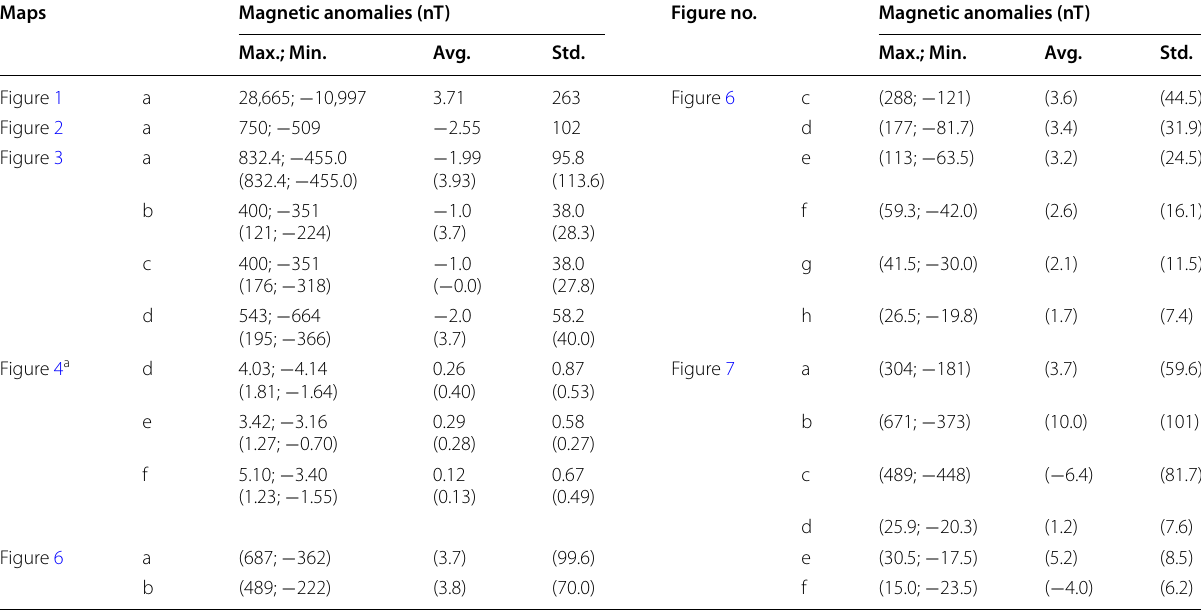
See Table 1 for the abbreviations of the listed statistics. The numbers in parentheses are for the Australian mainland and Tasmania a The S360 model statistics of maps a, b, and c are listed in Table 2